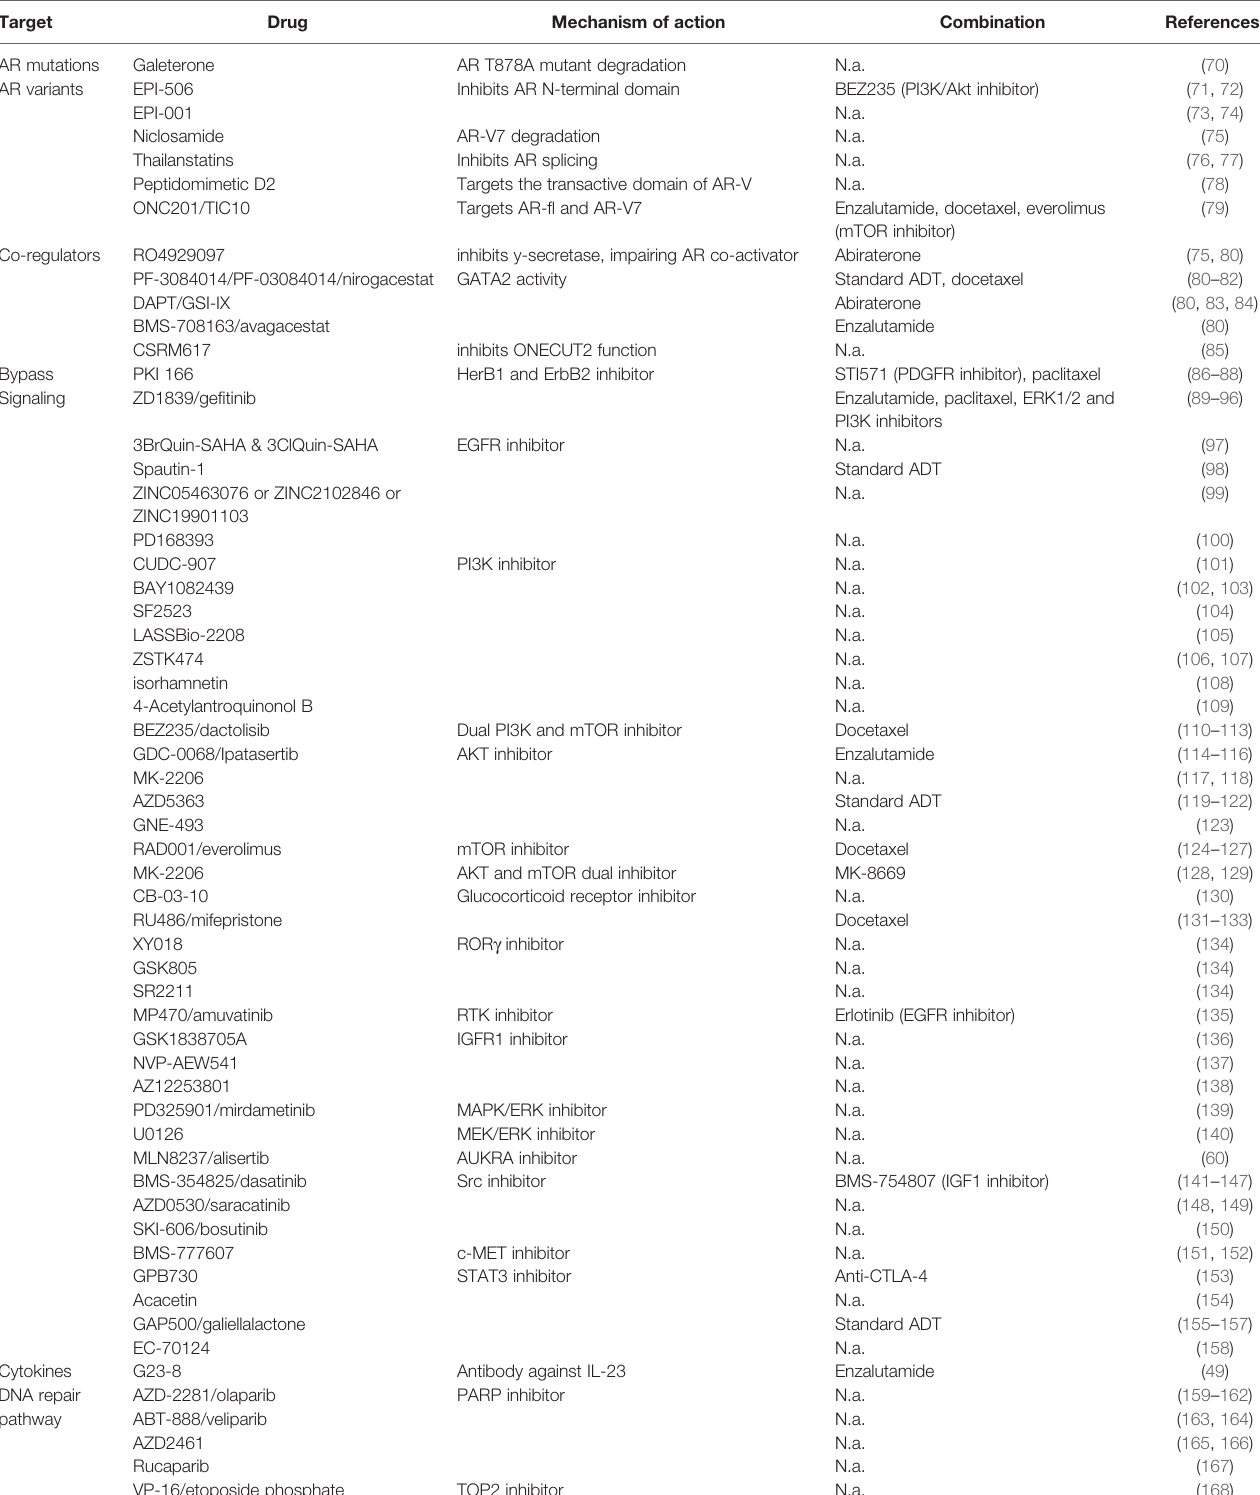
TABLE 1 | Potential targets and drugs for the management of therapy resistant prostate